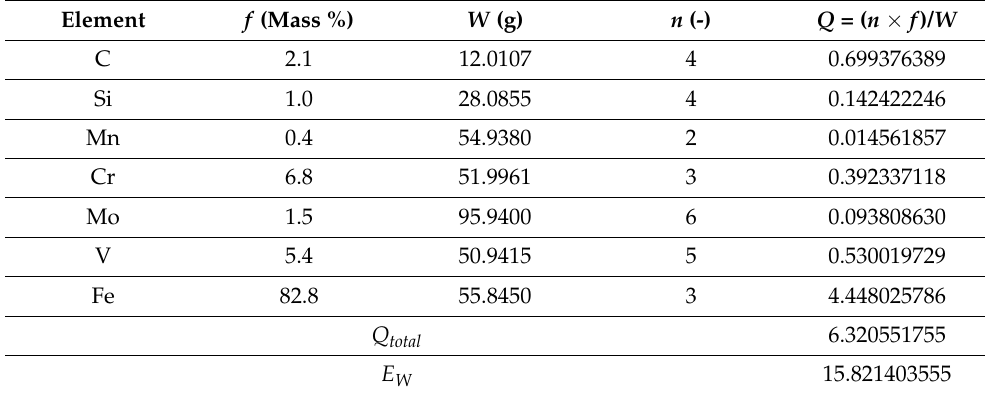
Table 2. The mass percentage, f , atomic weight, W , most common valance, n , electron equivalents of the main elements in the Vanadis 6 steel, Q , and calculated electron equivalent of the steel, Q total , as well as its equivalent weight, E w